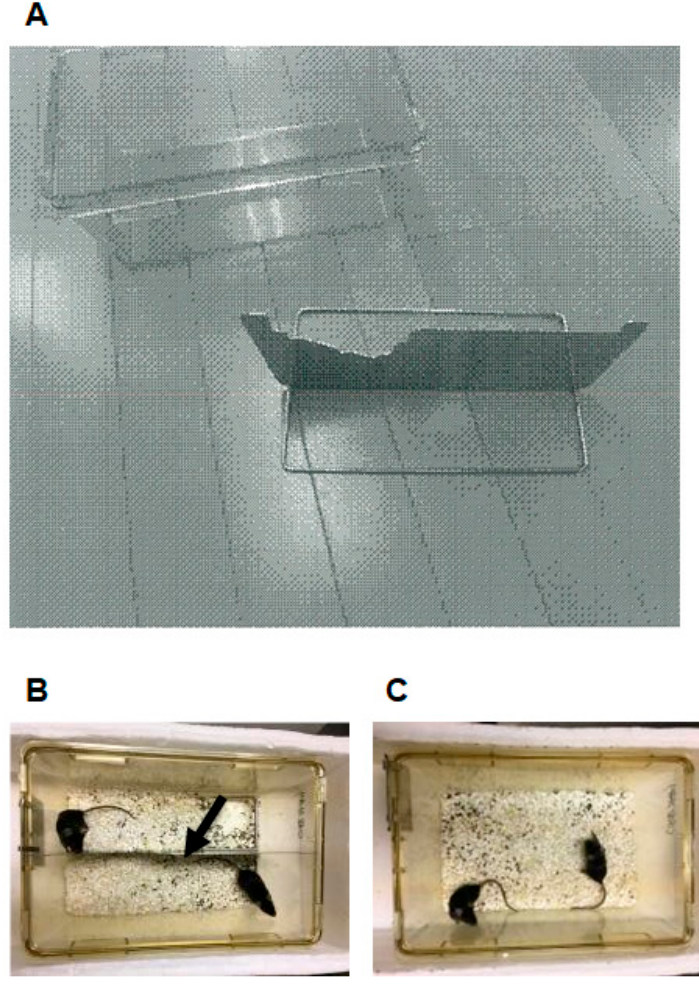
Figure 5. The photo of a cage, a partition and confrontational housing. ( A ) A partition and a cage. ( B ) Two mice were housed separately in the cage (Arrow indicates partition). ( C ) The partition was removed.